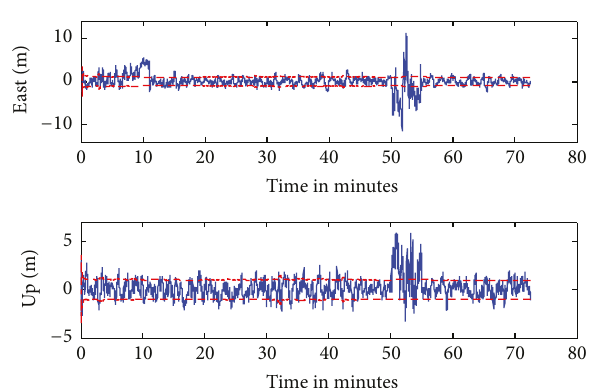
Figure 5: Position error obtained from the proposed